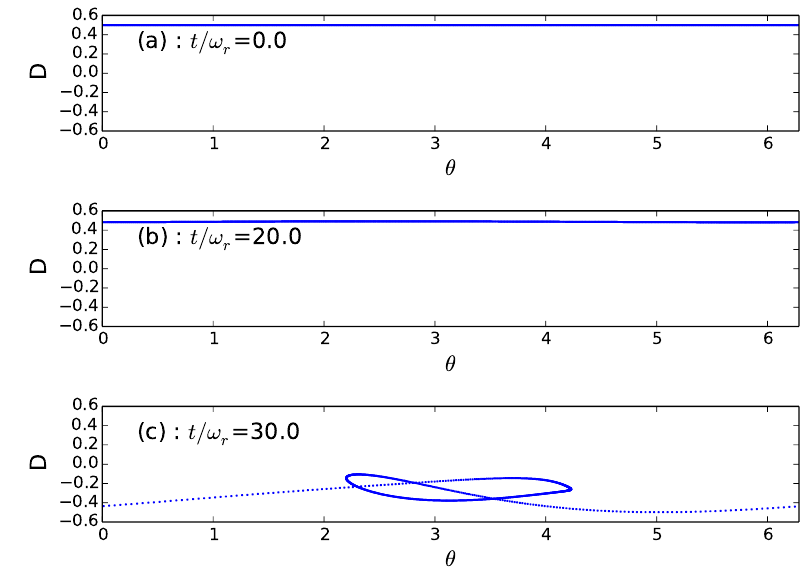
, D ) for each atom j = 1 .. 1000 j j , ( b ) t = 20 ω − 1 and ( c ) t = 30 ω − 1 in the case of strong excitation. The r r r